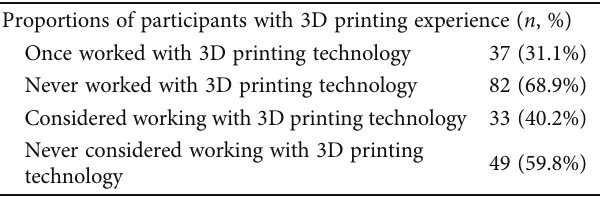
Table 3: Details on experience with 3D printing of the